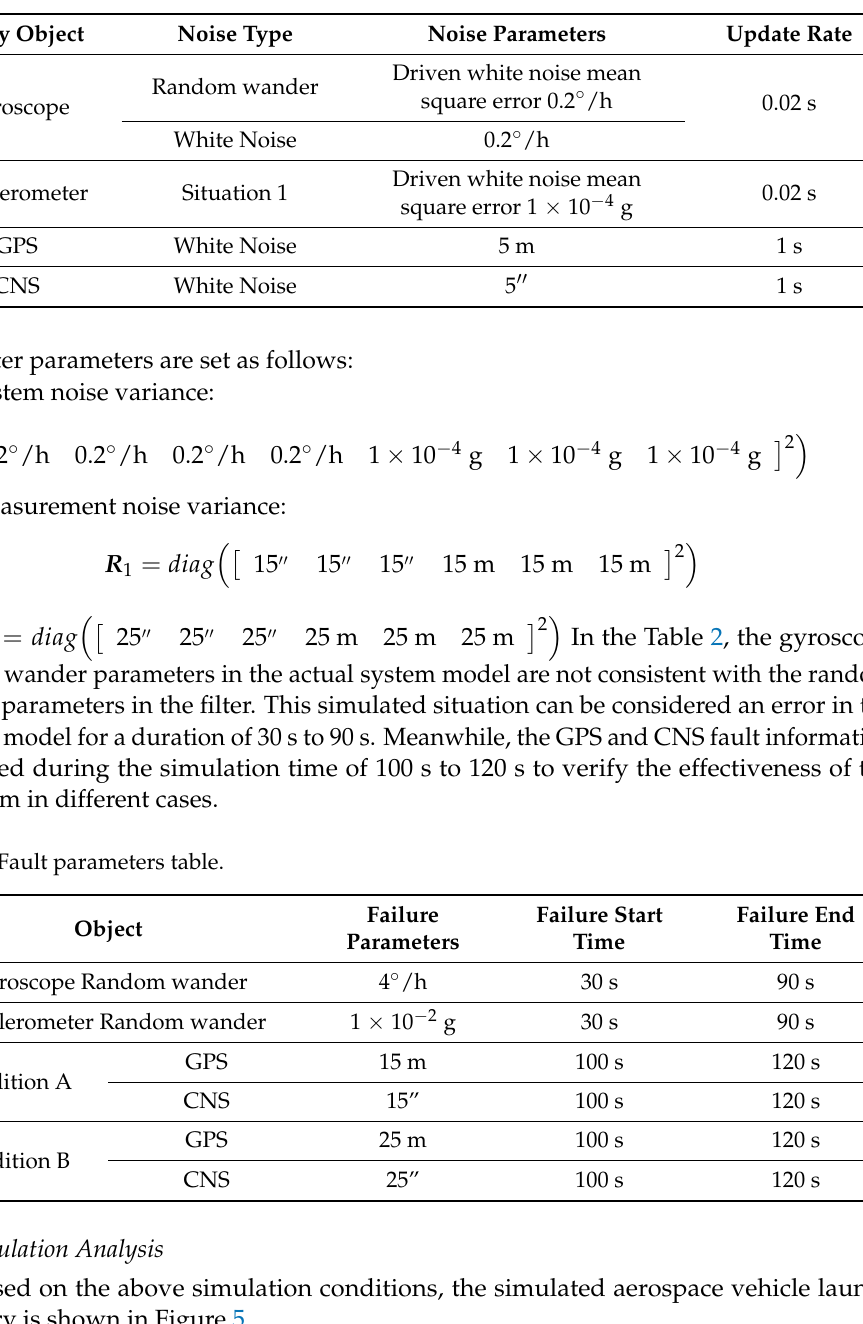
Table 1. Sensor simulation parameter setting.